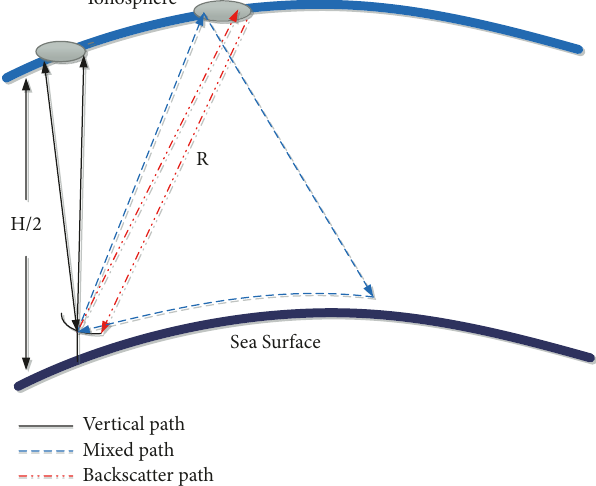
Figure 1: Propagation paths of HFSWR ionospheric